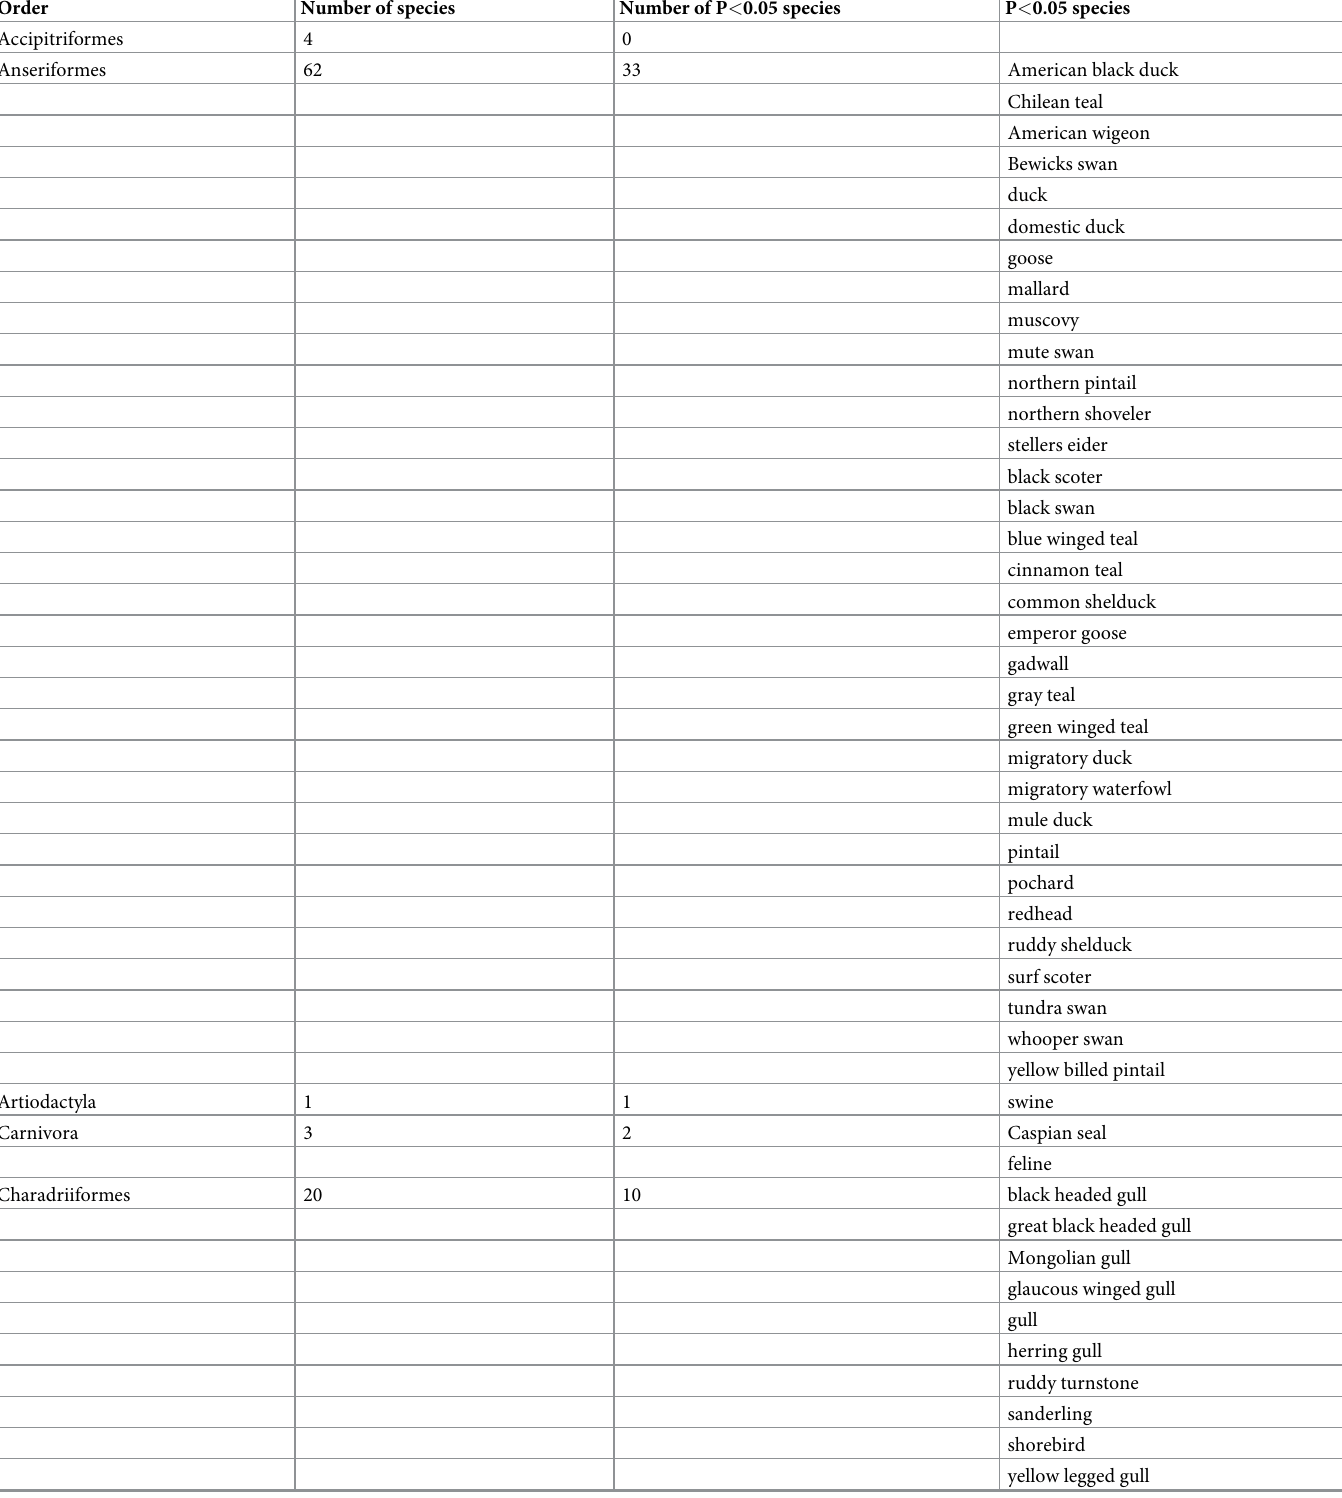
Table 1. Correlation of bird species with